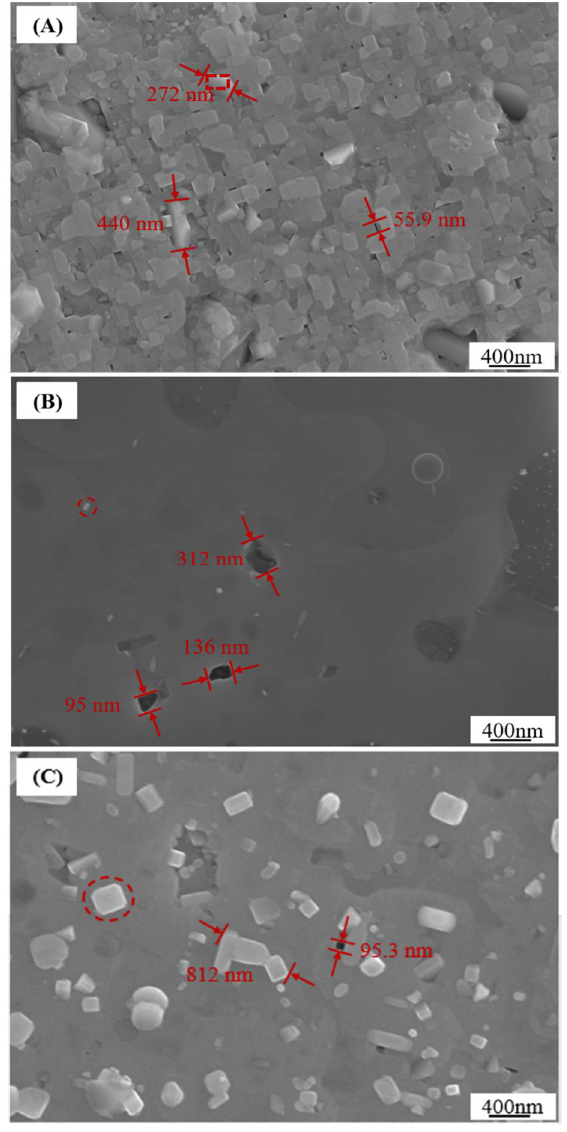
Figure 7. The secondary electron images of YBCO films from low vacuum pyrolysis films treated at ( A ) 810 °C and ( B ) 815 °C for 30 min, respectively. The SEM images of YBCO films from conventional ( A ) 810 ◦ C and ( B ) 815 ◦ C for 30 min, respectively. The SEM images of YBCO films from conventional film treated ( C ) at 810 °C for 1 h. film treated ( C ) at 810 ◦ C for 1